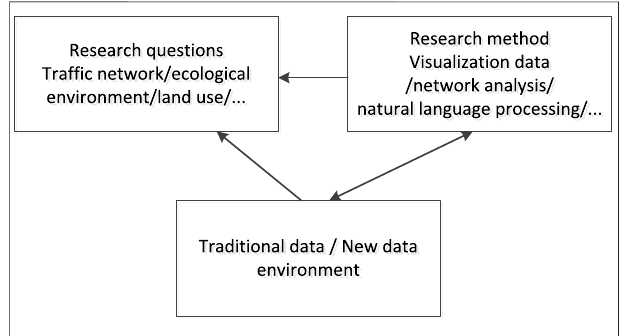
FIGURE 1 | Overall framework of quantitative urban